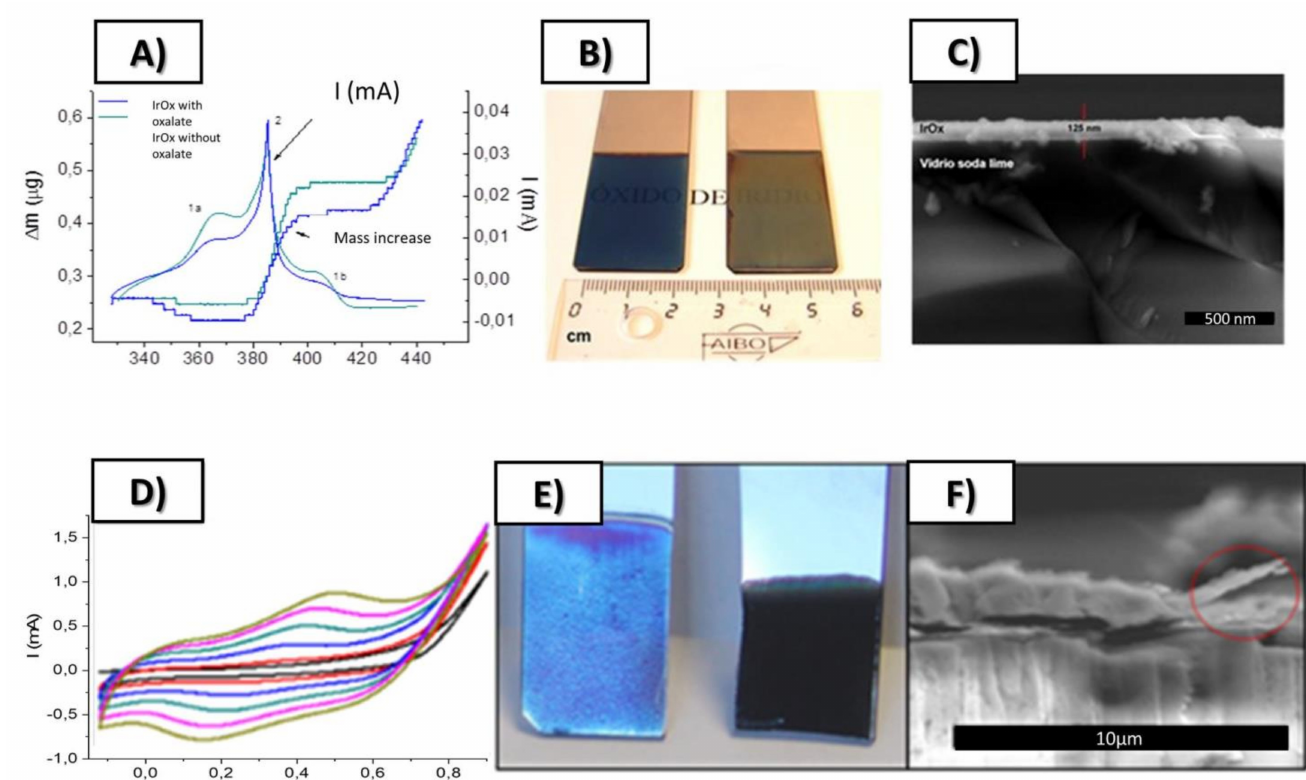
Figure 2. Top: ( A ) Simultaneous cyclic voltammetry and ECQM mass changes during dynamic Electrodeposition of IrO x involving mass deposition and K + intercalation/deintercalation, ( B ) SEM lateral images of resulting coatings on Pt (12 nm) glass slides, ( C ) Macroscopic images of IrO x deposited on Pt (12 nm)-Ti (5 nm)-glass substrates. Bottom ( D ) Typical electrodeposition Cyclic voltammetry of IrO x -Nanocarbon hybrids (this case IrO x -NGO) ( E ) macroscopic images showing that the first layers are mostly IrO x and ( F ) SEM lateral images of the coatings. From ref. [24,29] Published with permission of